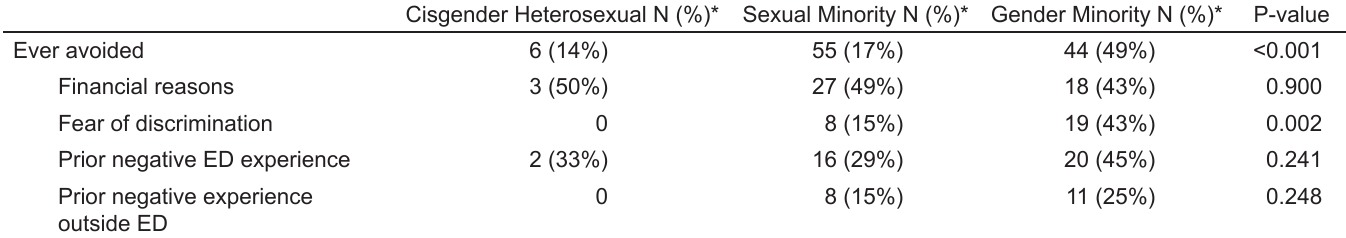
Table 3. Number of patients reporting having ever avoided the emergency department by sexuality and gender identity.